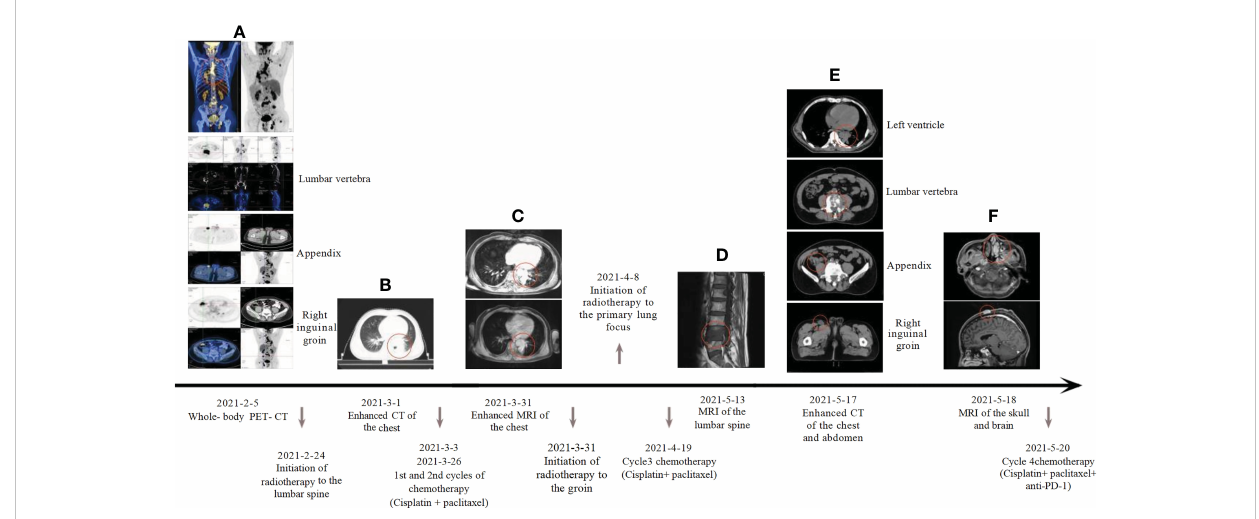
FIGURE 2 Systemic treatment strategies: (A) Whole-body PET-CT: maximum standardized uptake value: lung tumor 10.6, cecum 11.2, lumbar vertebra 15.7, inguinal groin 10.7, left ventricle 9.0, Cranial top skin 18.6; (B) Baseline computed tomography-enhanced CT of the chest; (C) The patient ’ s chest enhancement MRI was reassessed two weeks after chemotherapy; (D) MRI of lumbar spine metastases; (E) Review of chest, abdomen and pelvic enhancement CT; (F) MRI of the head suggests nasal and scalp